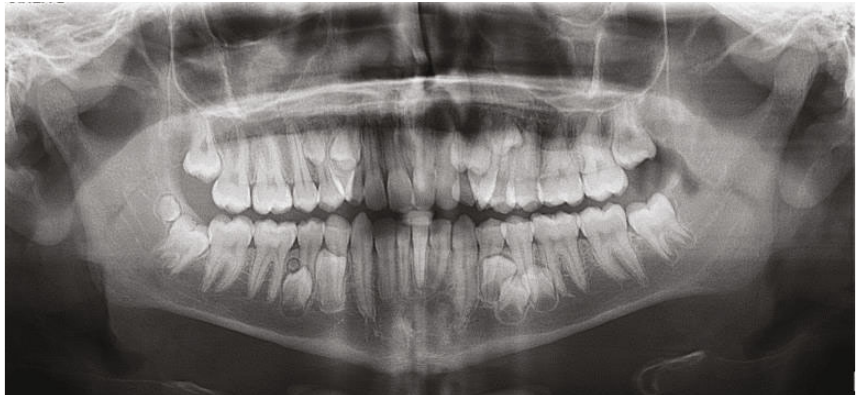
Figure 2: The original routine panoramic radiograph, showing supernumerary